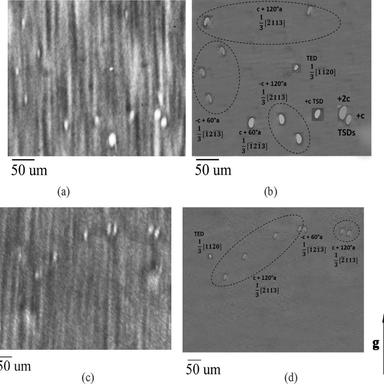
Grazing incidence monochromatic beam x-ray topograph (g = 1124; 9.37 KeV) of two small areas (a, c) and simulated images (b, d) showing Burgers vectors determined for each individual threading dislocation.